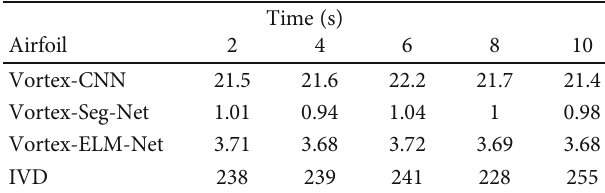
Table 5: Vortex-CNN execution time, Vortex-Seg-Net execution time, Vortex-ELM-Net execution time, and IVD execution